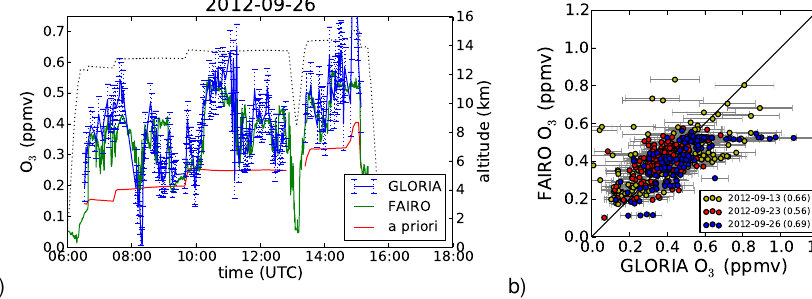
Figure 9. Comparison of retrieved O 3 125 m below flight level and O 3 measured by FAIRO. See also Fig. 7 and Tab. 4.